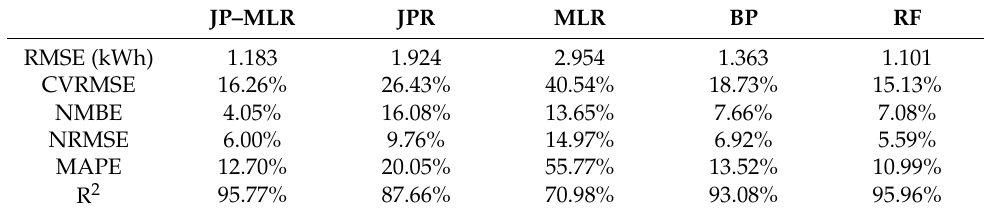
Table 7. Comparison of evaluation metrics for 4 models.